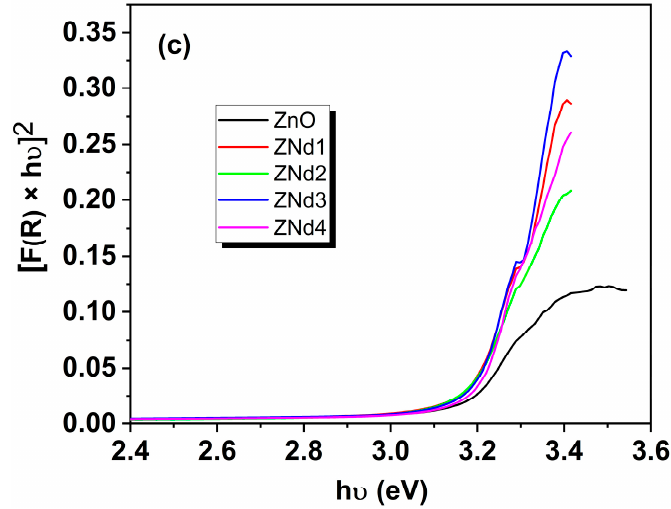
(cid:3117) (cid:3118) ( c ) plo tt ed against photon en-